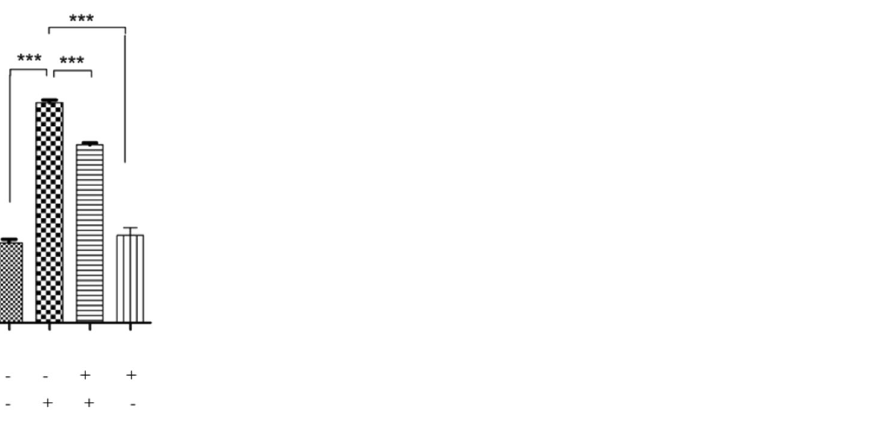
Figure 5. Effect of OLE on Ca 2+ levels. Rotenone administrated group showed increase in Ca 2+ levels (***p < 0.001) than control. Additionally in OLE-treated group, significantly reduced Ca 2+ level was found (***p < 0.001). The results are provided as mean SEM (n =